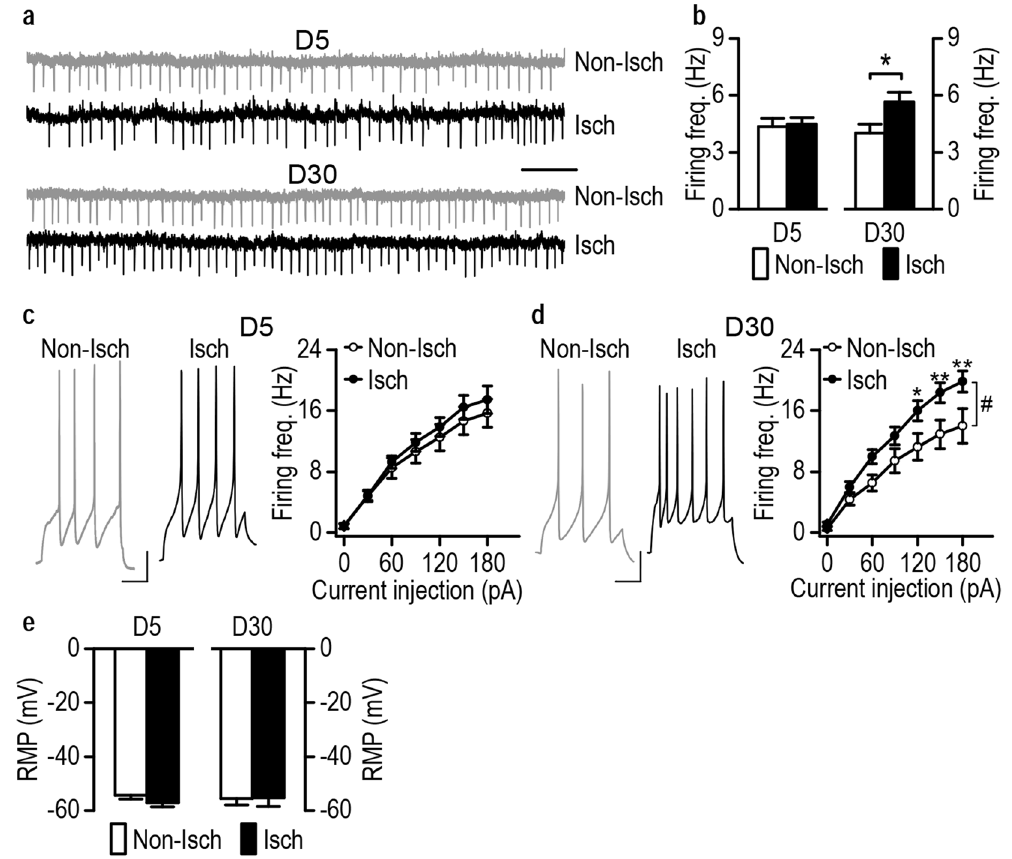
Figure 5. Stroke enhances spike firing activity of SNc neurons in alcohol-drinking rats. Rats were trained to consume alcohol using the 2-bottle choice procedure and stroke was induced as above. Midbrain slices were prepared on D5 and D30 post-stroke, and firing activity of SNc neurons were measured. ( a ) Sample traces of spontaneous firing of SNc neurons on the ipsilesional ischemic (Isch) and contralesional non-ischemic (Non-Isch) sides on D5 and D30. ( b ) Bar graph showing similar spontaneous firing frequencies on D5 (left) and increased spontaneous firing frequency on the Isch side on D30 (right), as compared to the Non-Isch side. * p < 0.05, t test. D5: n = 9 (Non-Isch) and 12 (Isch) neurons from 6 rats per group; D30: n = 12 neurons from 7 rats (Non-Isch) and 10 neurons from 6 rats (Isch). ( c ) Stroke did not change SNc neuron excitability on D5. Sample traces of membrane potentials following two 500-ms current injections are shown for the Non-Isch (left) and Isch (middle) sides. Right, relationship between the injected current magnitude and firing frequency of SNc neurons on both sides. n = 12 (Non-Isch) and 14 (Isch) neurons from 7 rats per group. ( d ) Stroke produced an increase in excitability on D30. Sample traces of membrane potentials following two 500- ms current injections are shown for the Non-Isch (left) and Isch (middle) sides. Right, relationship between the injected current magnitude and firing frequency of SNc neurons on both sides. # p < 0.05 by two-way RM ANOVA; * p < 0.05, ** p < 0.001, and # p < 0.05 by post-hoc SNK test. n = 11 neurons from 7 rats (Non-Isch) and 11 neurons from 8 rats (Isch). ( e ) Bar graphs showing no difference between the resting membrane potentials (RMP) on the Non-Isch and Isch sides on D5 (left) or D30 (right). D5: n = 12 neurons from 5 rats (Non-Isch) and 14 neurons from 6 rats (Isch); D30: n = 11 neurons from 7 rats (Non-Isch) and 11 neurons from 8 rats (Isch). Scale bars: 1 s ( a ) and 150 ms, 10 mV ( c , d